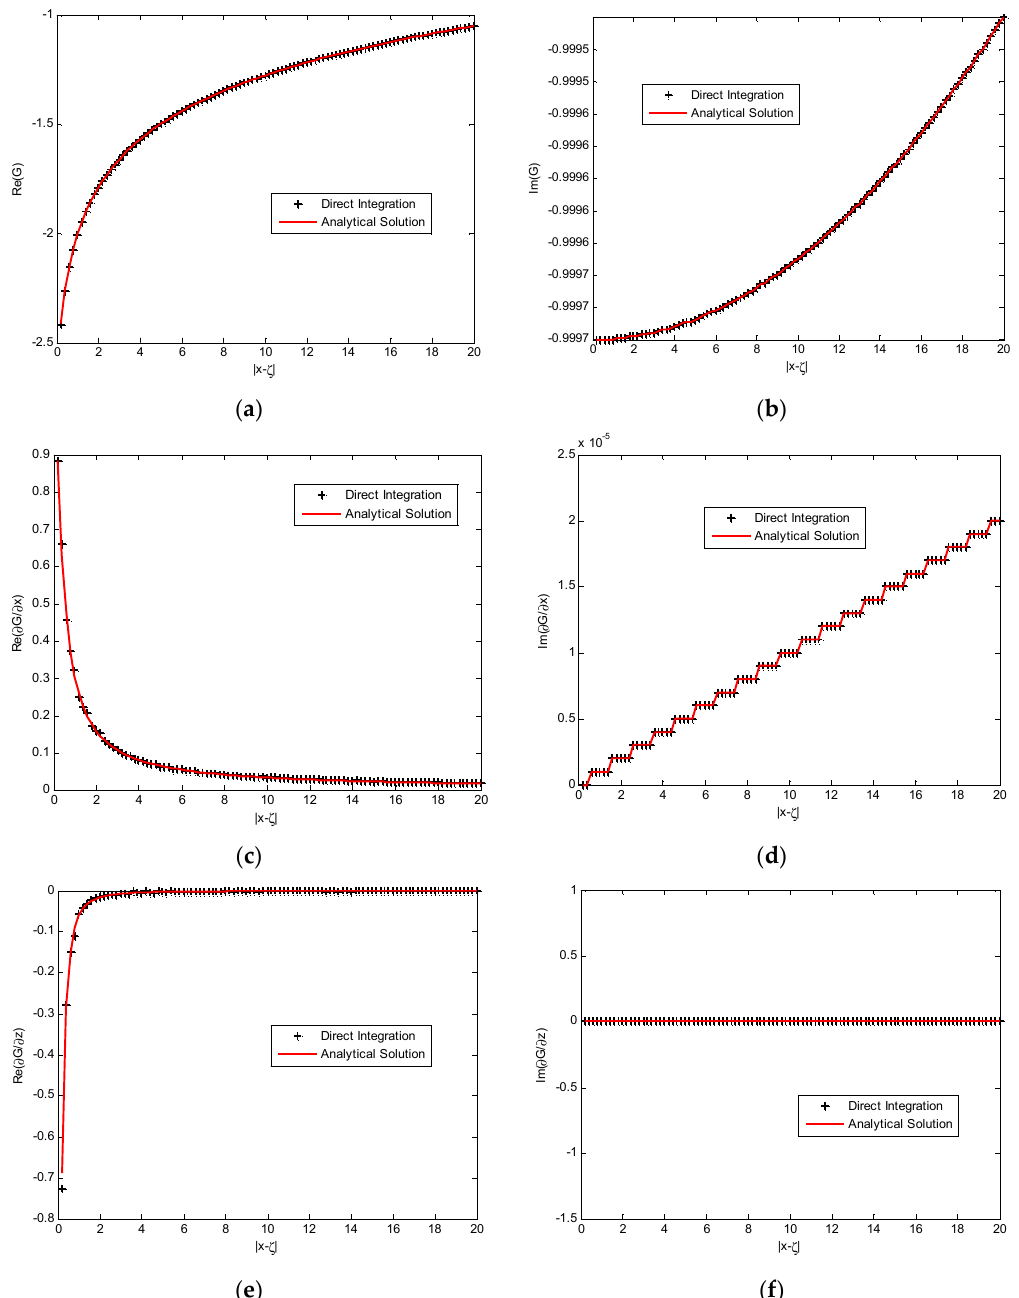
Figure 6. Comparison of two methods for calculating Wehausen’s Green function and its derivatives ( K = 0.001 m − 1 , ζ = − 0.1 m, z = − 0.2 m). For captions of the subplots please refer to Figure 5.